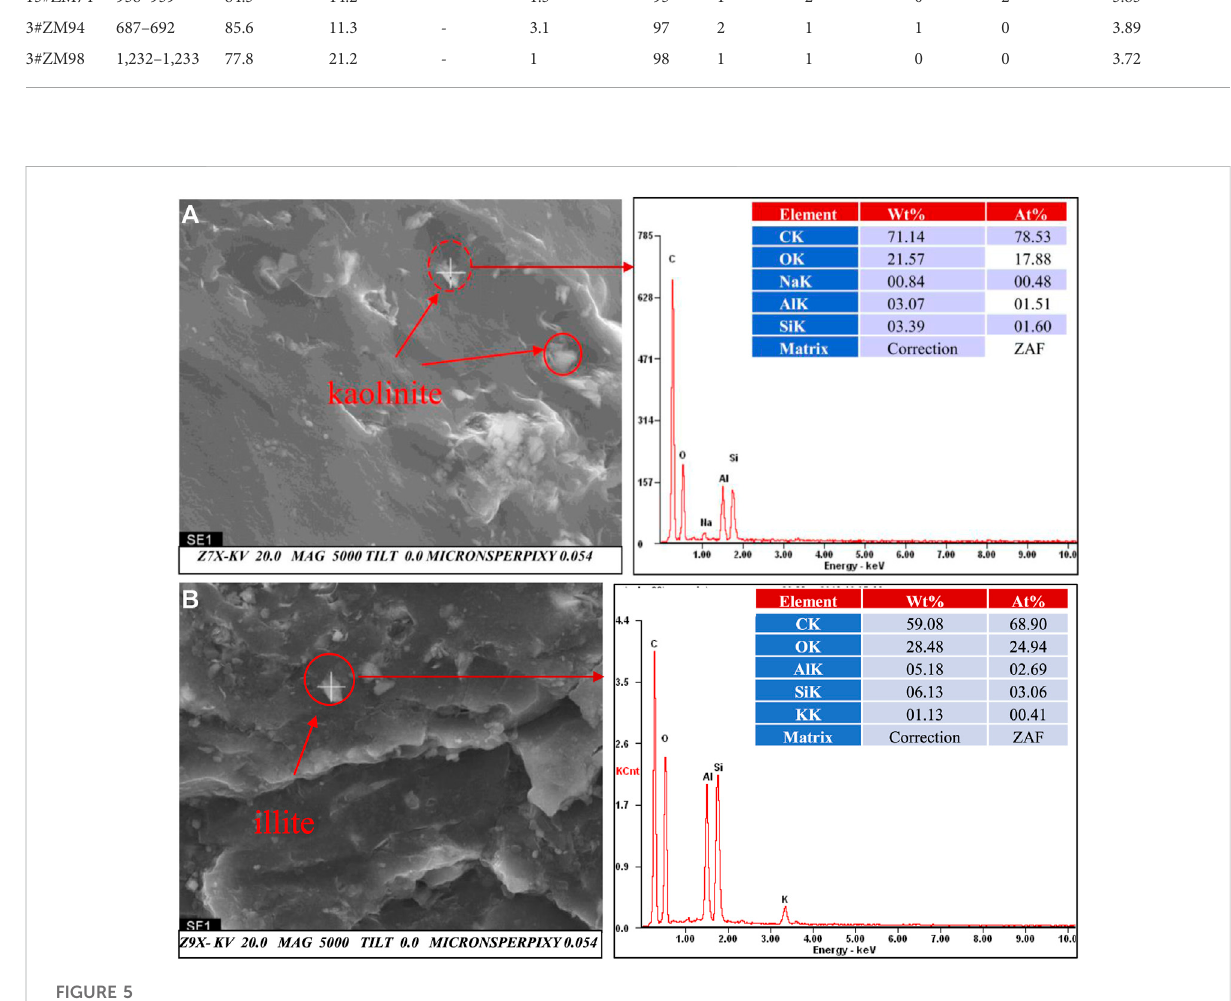
FIGURE 5 EDS of